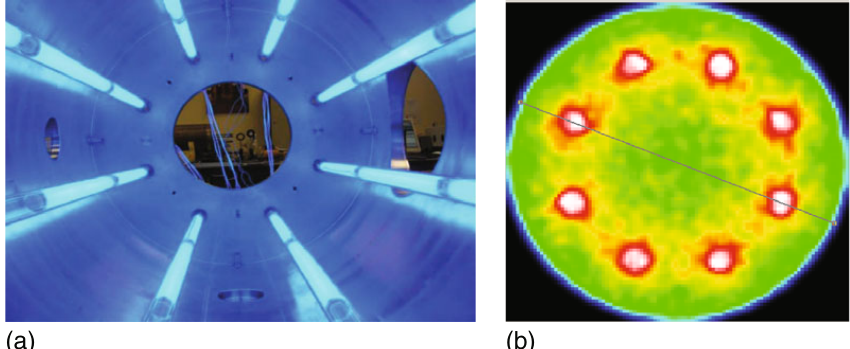
Fig. 3. (a) Lamps inside the HIRAC chamber. (b) Calculated radiation distribution across the HIRAC